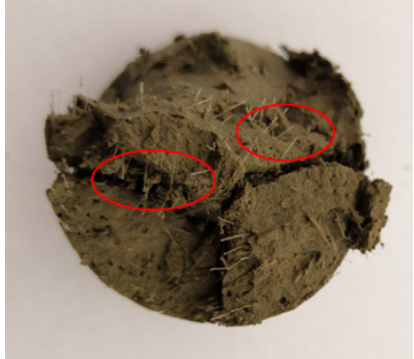
Figure 9. Sectional view of PCC after failure.